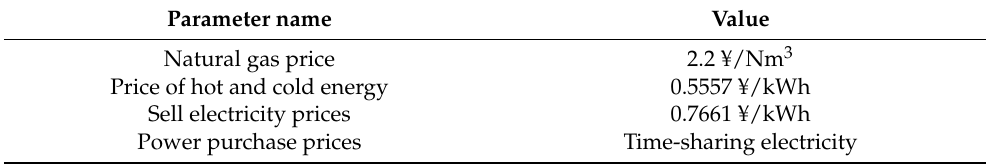
Figure 6. Price of buying or selling electricity. Table 2. Multiple energy price parameters.